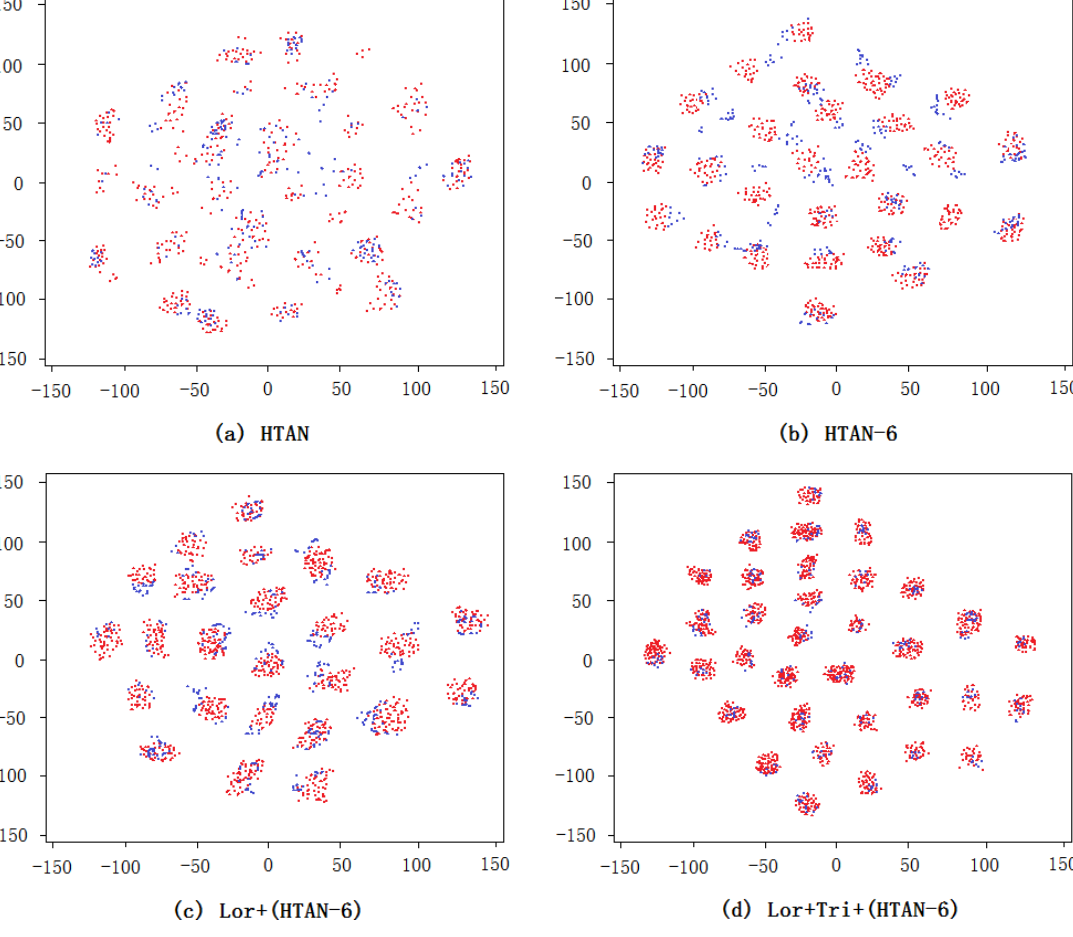
Figure 6. Visualization of images and feature distributions of source and target domains using T-SNE; the red and blue digits represent source Amazon (A) dataset and target Webcam (W) dataset